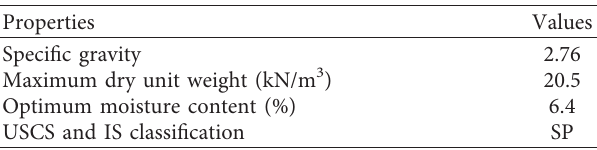
Table 3: Properties of used sand [20].